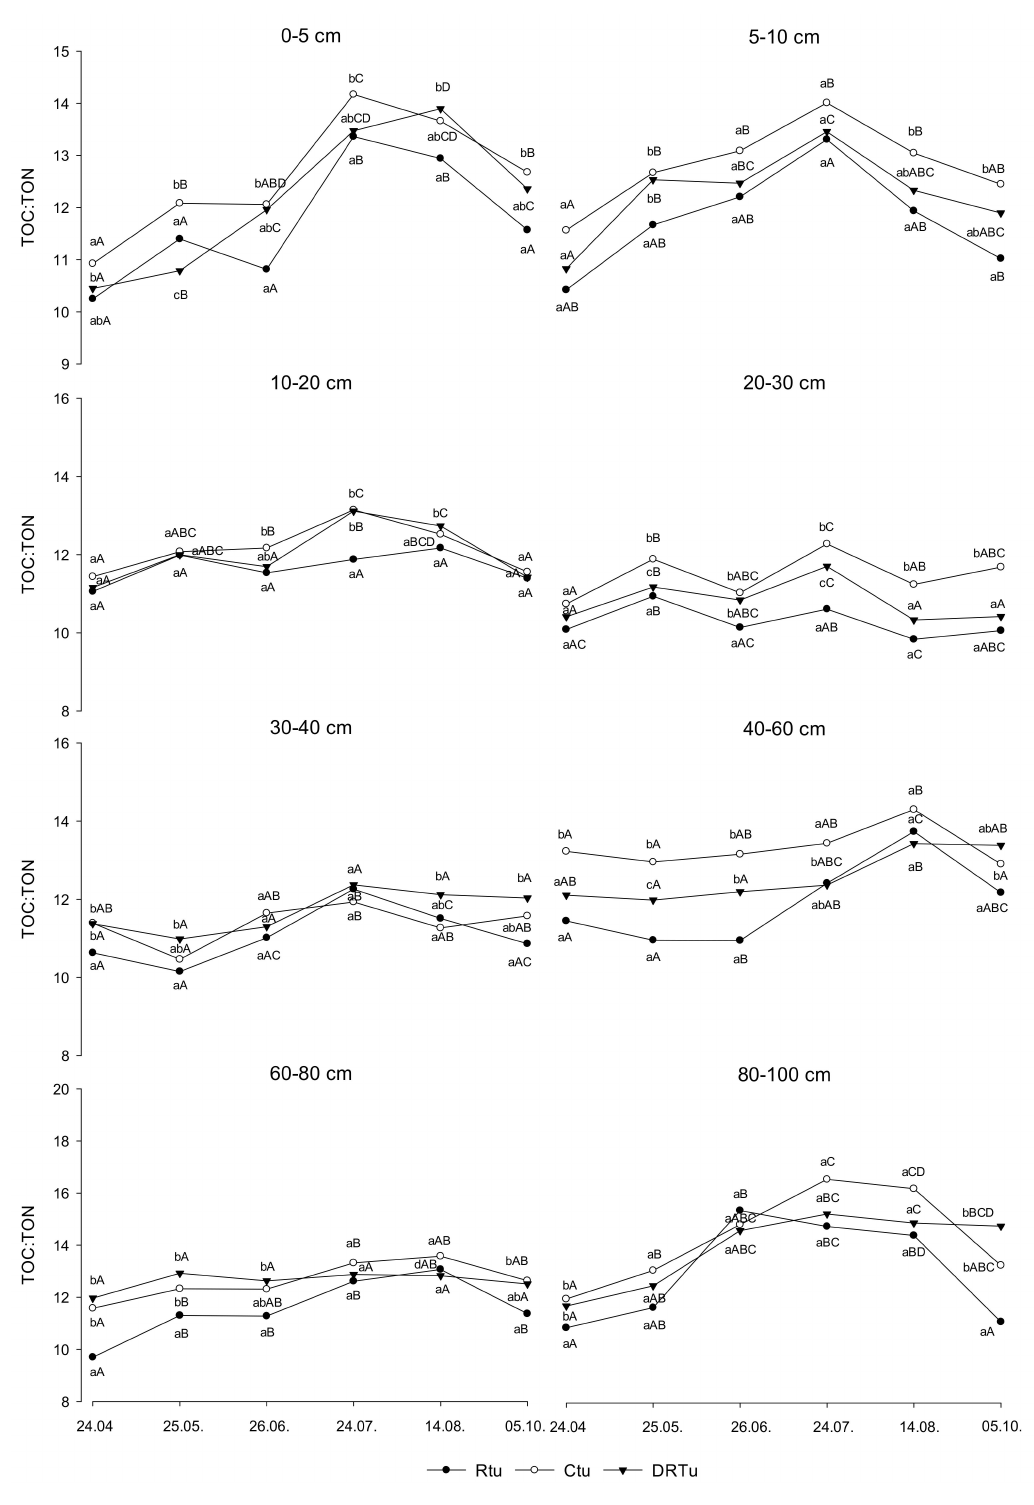
Figure 5. TOC:TN ratio changes in the 0–5, 5–10, 10–20, 20–30, 30–40, 40–60, 60–80 and 80–100 cm layers across the growing season under 14 years of continuous application: reduced tillage (RTu), conventional tillage (Ctu) and deep reduced tillage (DRTu). The plant was barley. Mean values by different lowercase letters demarcate a significant difference among different tillage adjustments within the same sampling time (significant differences a = 0.05). Mean values by different capital letters demarcate a significant difference among different sampling periods (significant differences a =